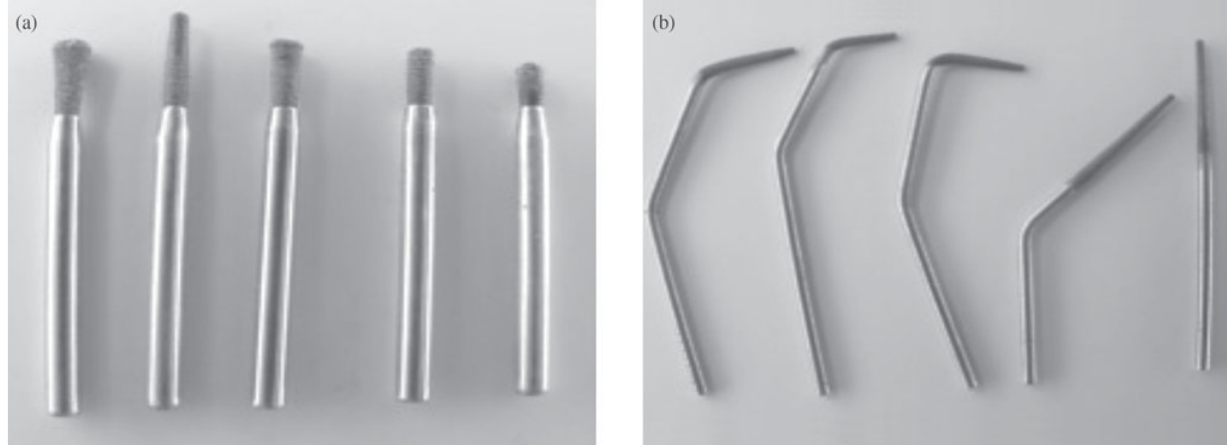
Figure 7. Examples of devices developed with molybdenum surface modification, a) Diamond burr used in very high rotation; b) used in high-energy ultrasound